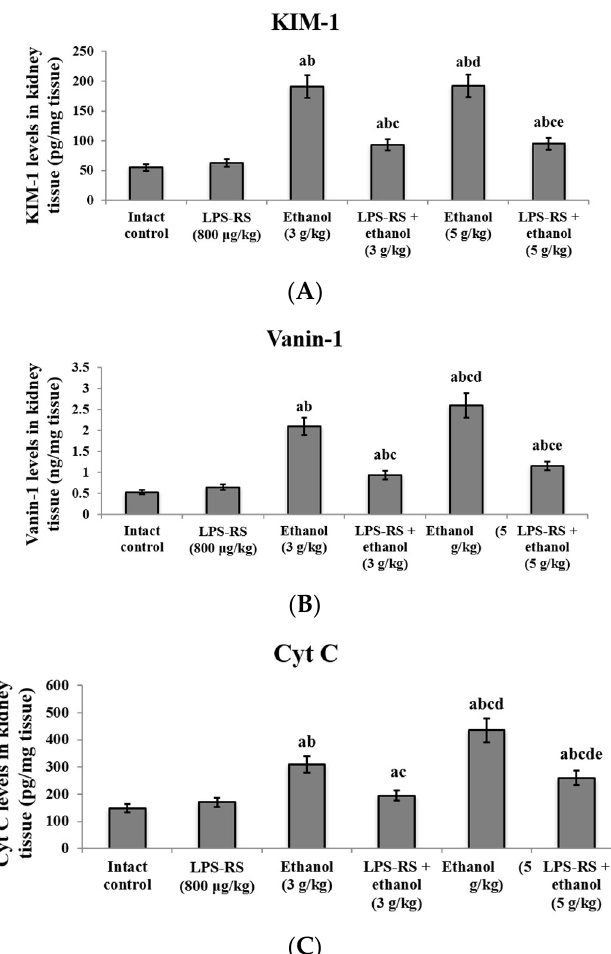
Figure 5. The effect of LPS-RS (800 μg/kg) on the levels of biochemical markers of kidney injury. ( A ) KIM-1, ( B ) Vanin-1 and ( C ) Cyt C in kidney tissue of the experimental rats. KIM-1, kidney injury molecule-1; Vanin-1, vascular non-inflammatory molecule-1; Cyt C, cytochrome C. Data are expressed as mean ± SD and analyzed using one-way ANOVA followed by Bonferroni’s post-hoc test ( n = 8–10). Differences were considered significantly different at p < 0.05. a vs. intact control; b vs. LPS-RS; c vs. ethanol (3 g/kg); d vs. LPS-RS + ethanol (3 g/kg); e vs. ethanol (5 g/kg).